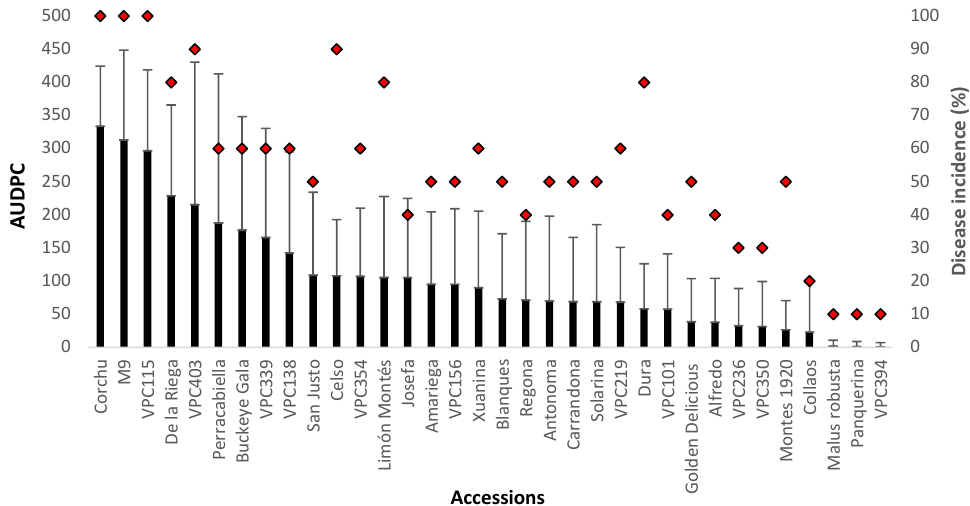
Figure 1. Mean area under disease progress curve (AUDPC; mean ± SD) and disease incidence (proportion of infected wounds as a percentage of the number of inoculated wounds) for detached shoots inoculated with a single N. ditissima isolate calculated 42 days post-inoculation. The solid black bars represent AUDPC values whereas the red rhombuses indicate the disease incidence percentage.